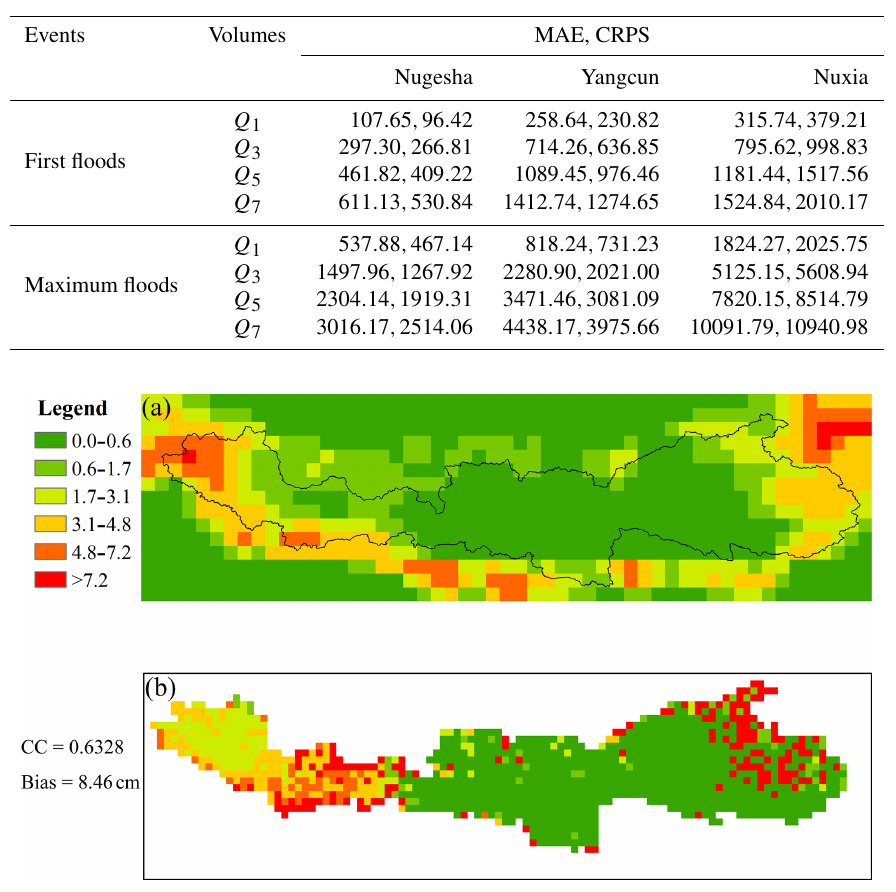
Figure 5. Spatial distribution of daily average snow depths derived from remote sensing (a) and simulation by S simulation (b) at Nuxia.